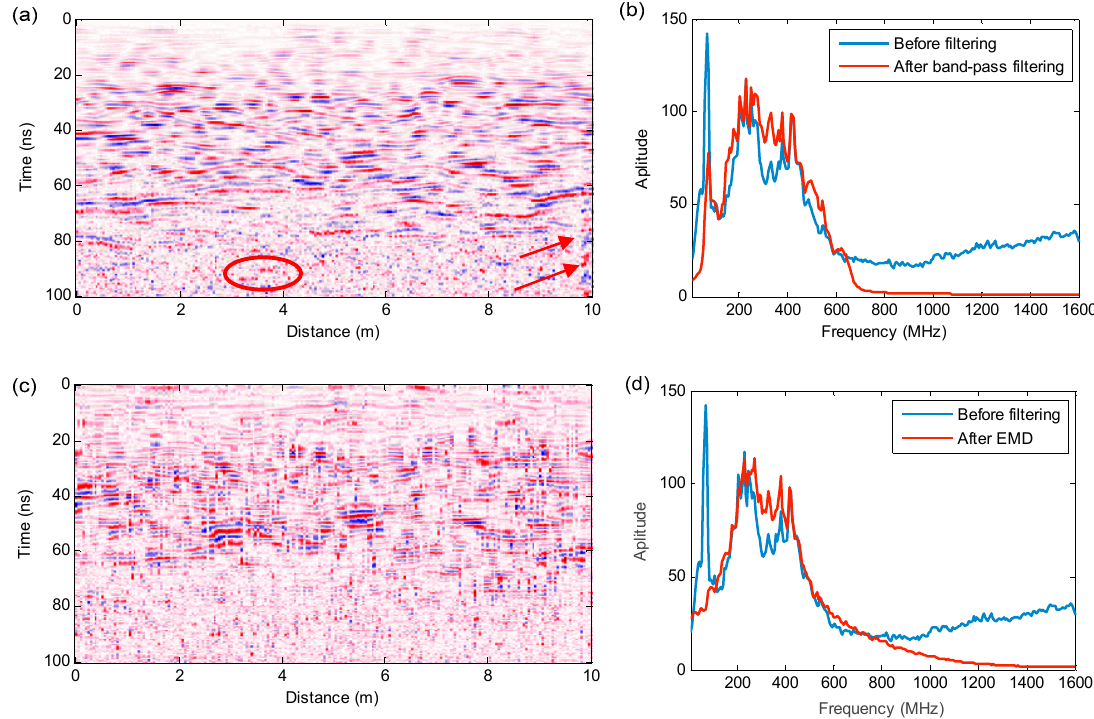
Figure 7. ( a ) The filtering result using band-pass filtering method; ( b ) the amplitude spectra of the results in Figures 6a and 7a; ( c ) the filtering result using EMD method; ( d ) the amplitude spectra of the results in Figures 6a and 7c.